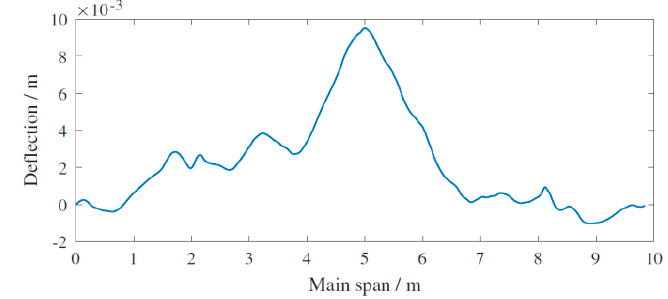
Figure 4. Deformation of main span depicted by continuous deflection.